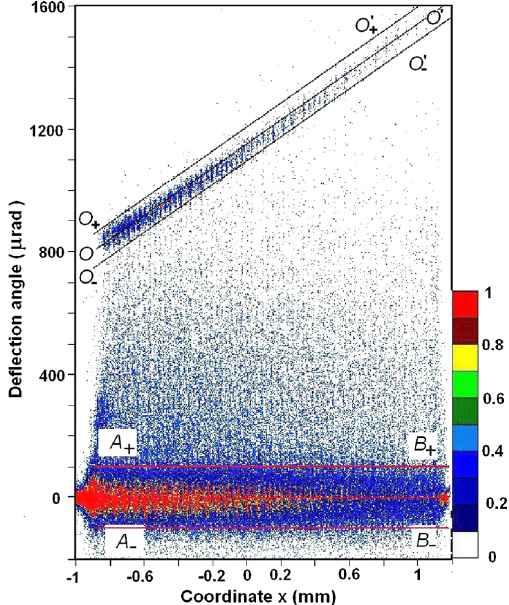
9. Beam intensity recorded by the microstrip detectors as a function of horizontal coordinate x and horizontal deflection angle. The area between lines A þ B þ and A − B − corresponds to nonchanneled particles which pass through the crystal after they were scattered. The line OO 0 corresponds to the center of the distribution of channeled particles, which passed along the full crystal length. The particles between A þ B þ and O − O 0 − correspond to the dechanneled fraction. The beam momentum is 180 GeV =c .